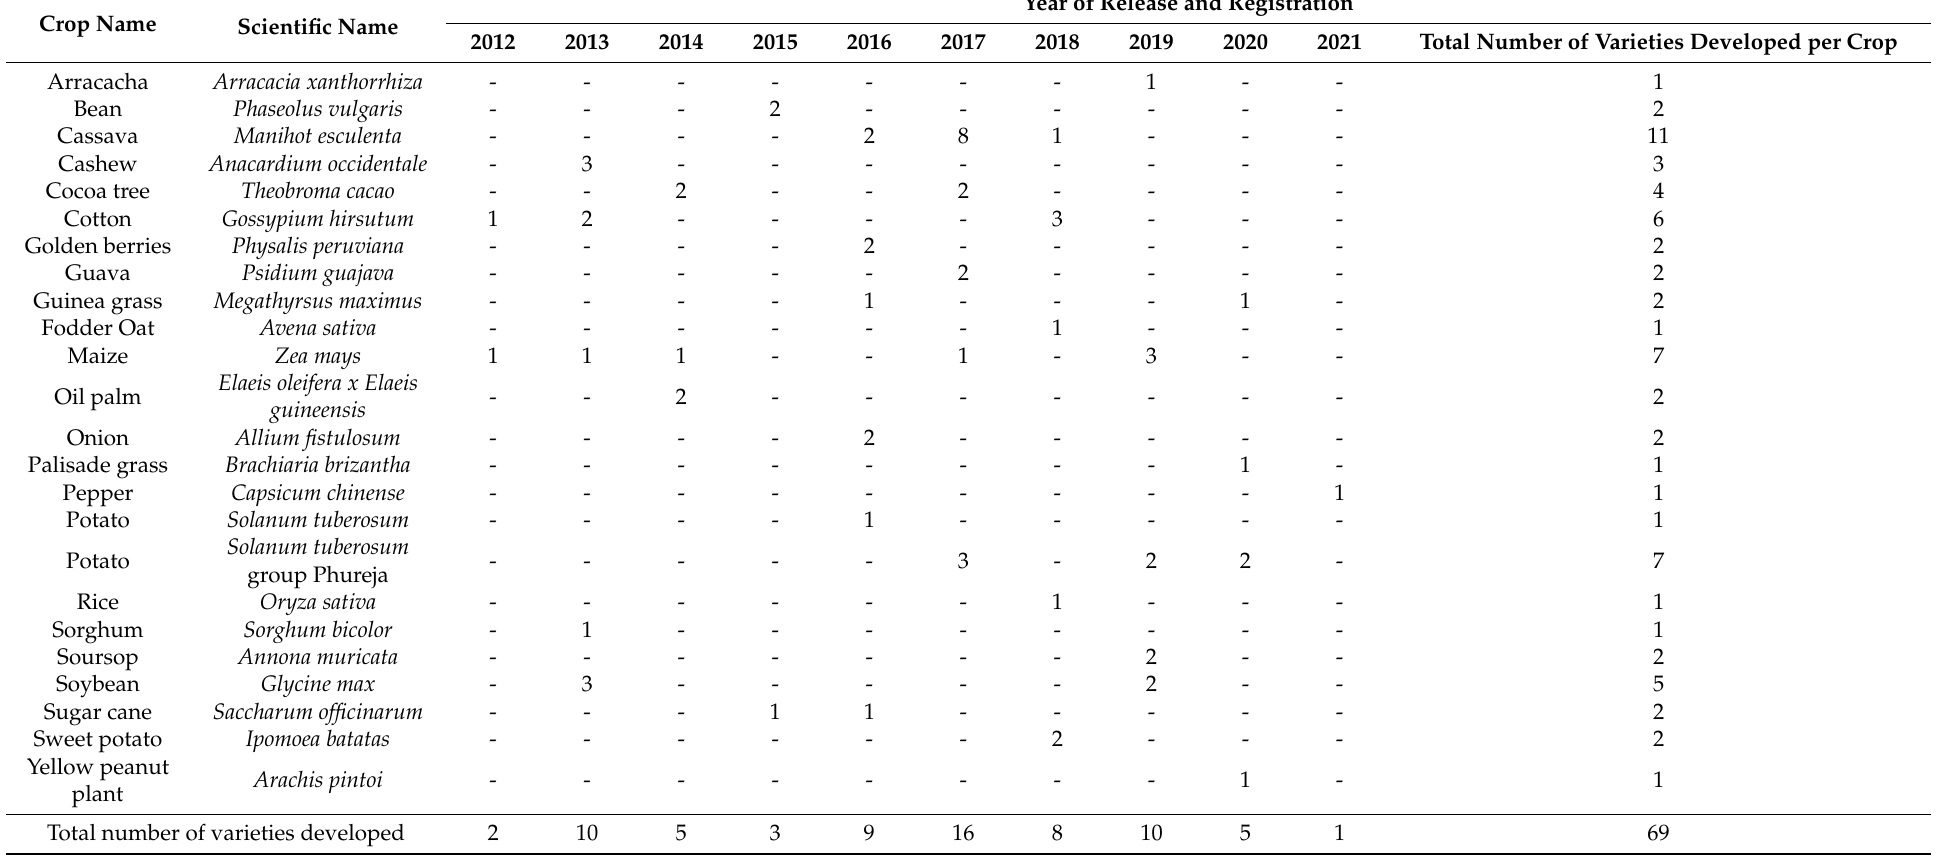
Table 1. The number of crop varieties released by A GROSAVIA and registered in the national list of varieties (Registro Nacional de Cultivares, RNC—ICA) between 2012 and 2021 in 24 crops. It is noted that 4 varieties of the 69 were registered in collaboration with other institutions: 2 maize varieties with CIMMYT, 1 bean variety with Harvestplus and CIAT, and 1 grass variety with CIAT. Moreover, 7 of the 69 new varieties used as parent material at least one accession conserved in the Colombian Plant Germplasm Bank: 2 of onion and 5 of potato (Phureja